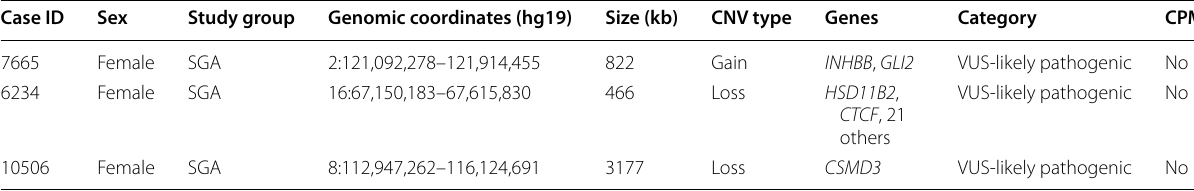
CPM confined placental mosaicism, VUS variant of uncertain significance